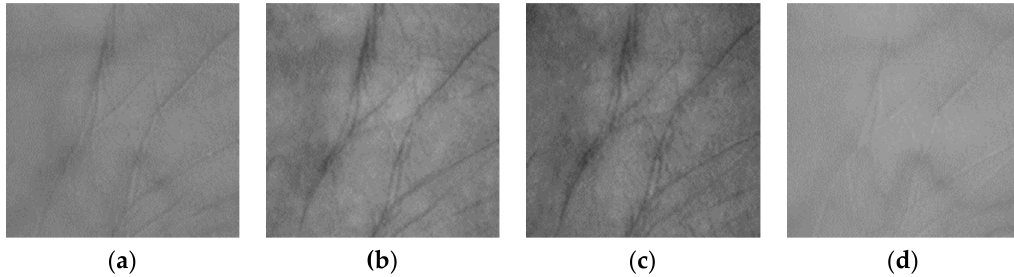
Figure 8. PolyU MPP (The Hong Kong Polytechnic University Multispectral Palm Print) samples from different spectra. ( a ) Red; ( b ) Green; ( c ) Blue; ( d ) NIR.